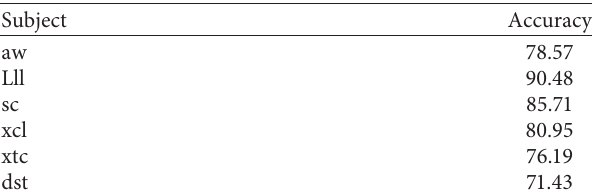
Table 2: Classification accuracy of the CSP-CNN